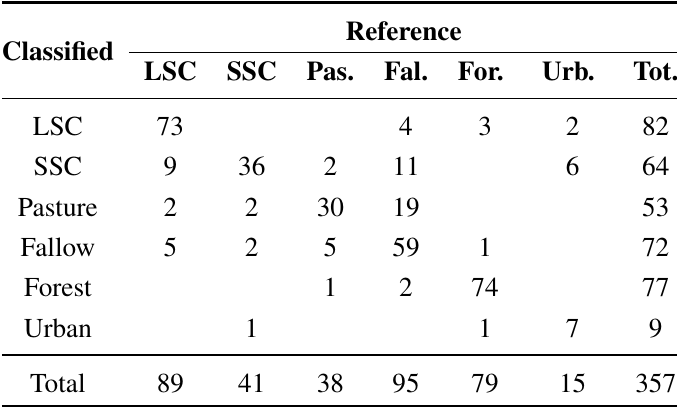
Table 4. Confusion matrix for the object-based classification of LS.